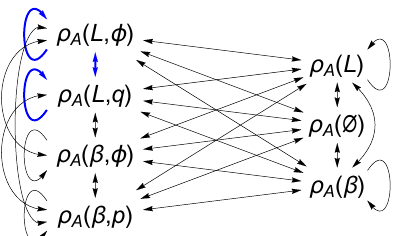
Figure 3. The 48 relative entropies we can calculate using OPE of the twist operators.